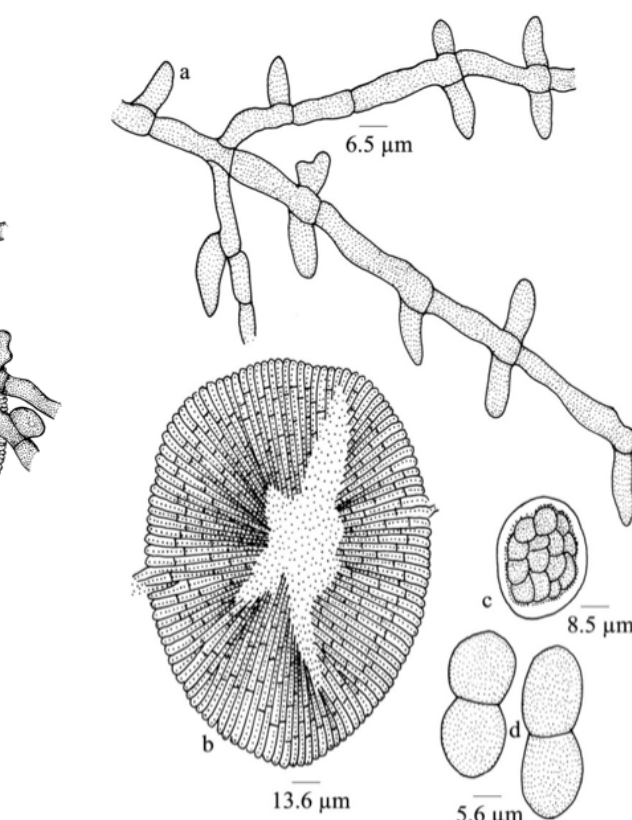
Figure 144. Asterina glycosmidigena a - Appressorium; b - Thyriothecium; c - Ascus; d - Ascospores